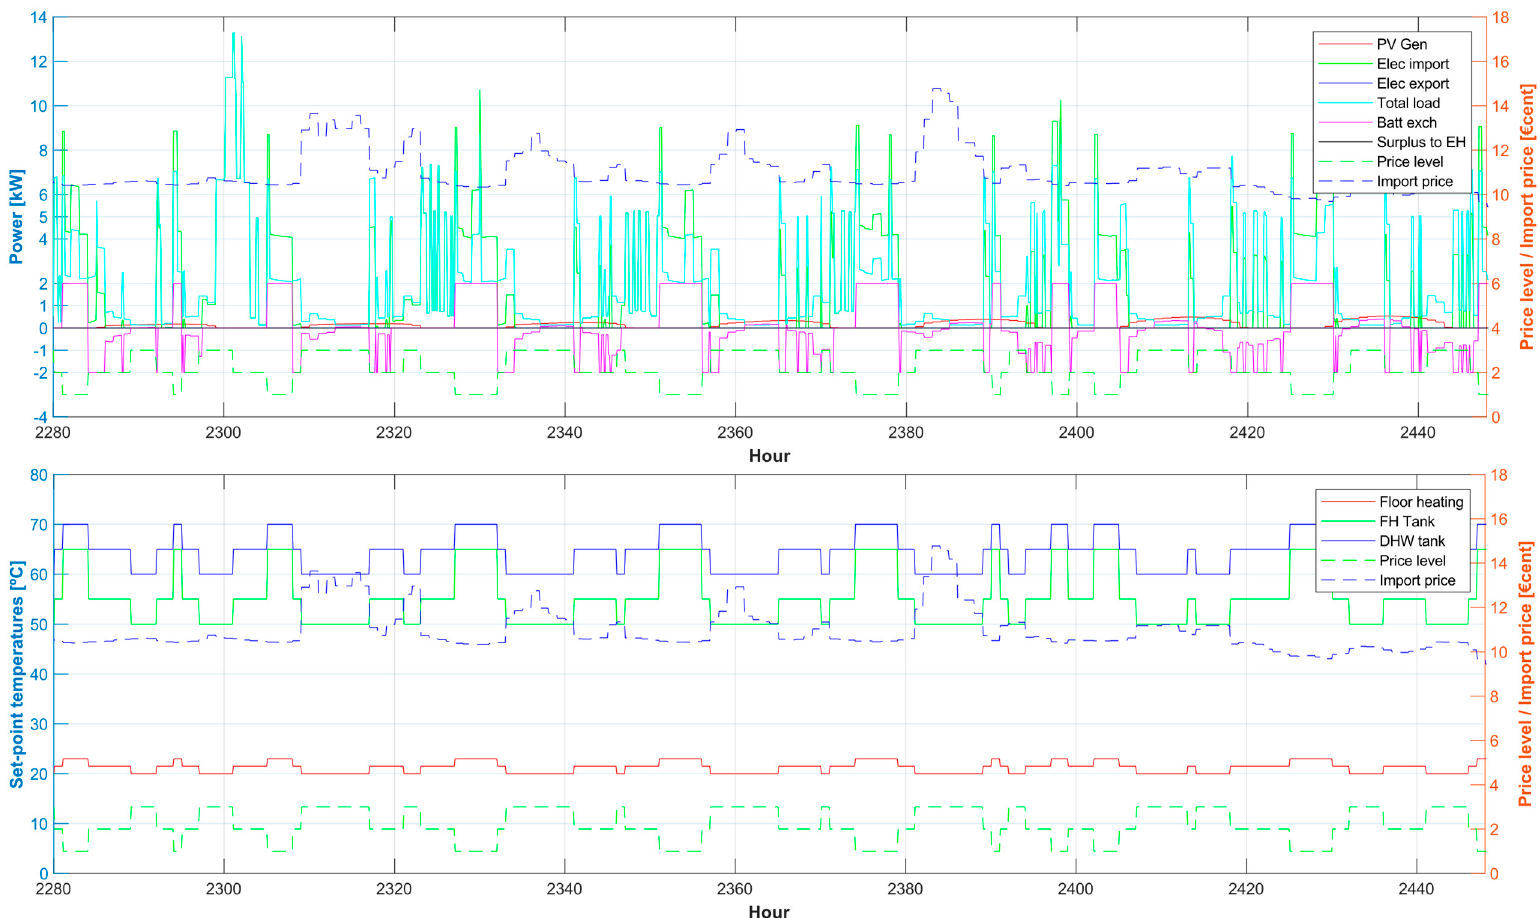
Figure 4. Example of the operation of the RBC from hours 2280 to 2448, corresponding to April 6 to 13 (Lowest LCC RBC parameters: Perc. PFP 12 h, Low: 20, High: 60). The top and bottom charts show the electricity and heat management actions, respectively. “Price level” is to be interpreted as Low = 1, Normal = 2, High = 3. Positive values of “Batt exch” indicate charging; negative values discharging.